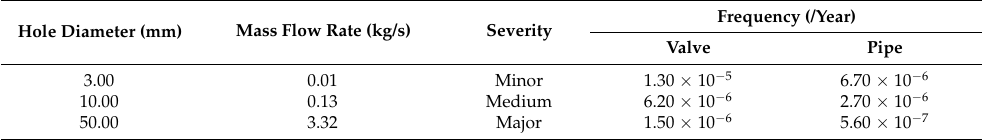
Figure 4. Two leak positions in the fuel supply deck of the LNG bunkering system. Table 3. OGP leak frequency tabulation for valves and pipes (from 1992 to 2015) [40].